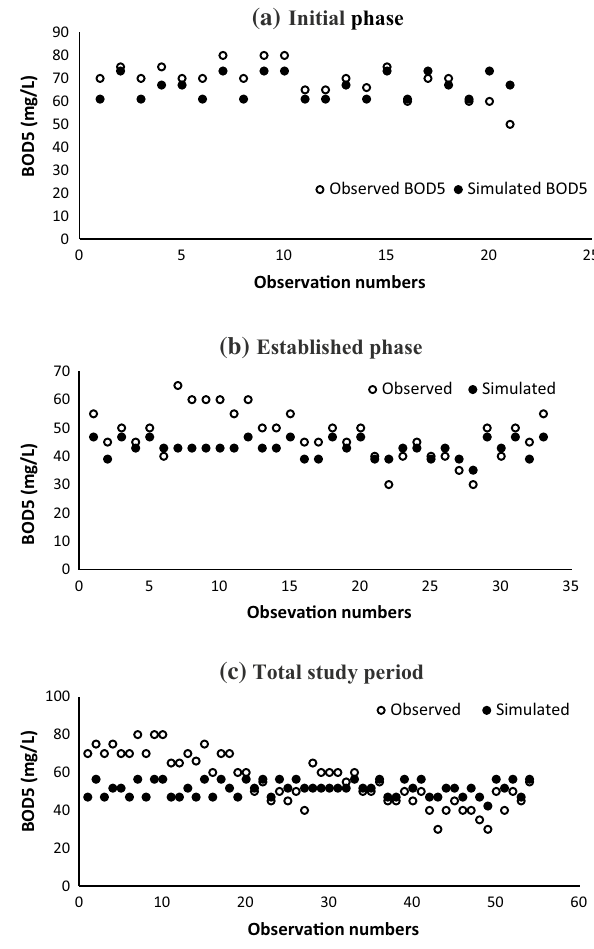
Fig. 5 Comparison of observed and simulated BOD for plug flow